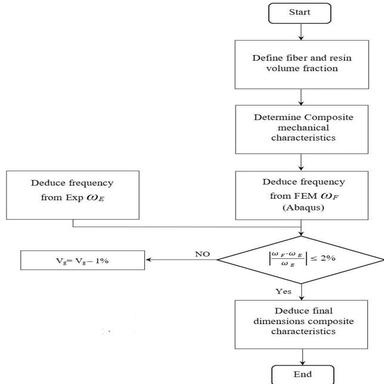
Flow chart for adjusting the fiber volume fraction of composite pipe.